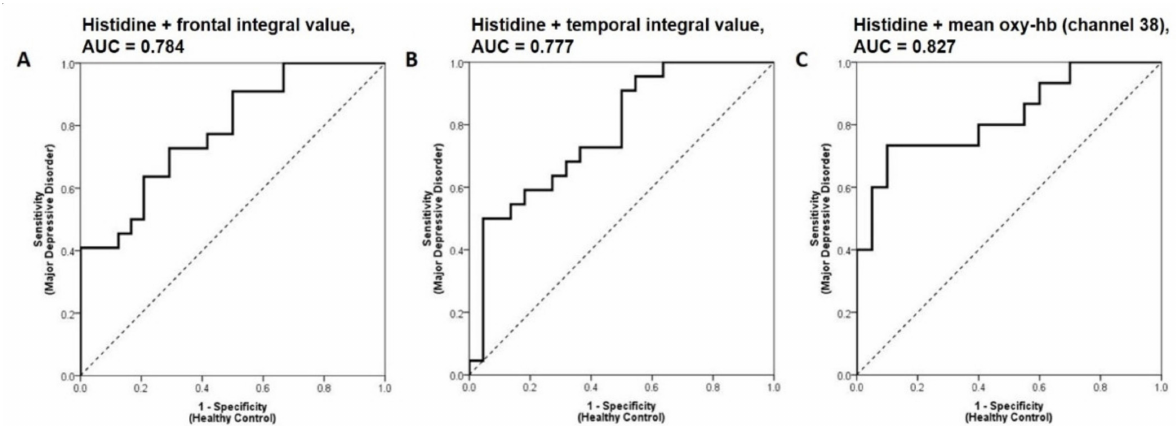
Figure 5. Receiver operating characteristic analyses using combined biomarkers of: ( A ) Frontal region integral values and histidine; ( B ) temporal region integral values and histidine; ( C ) histidine and the mean oxy-haemoglobin concentration in Channel 38 between patients with MDD and healthy controls. The optimal cut point was maximised using Youden’s